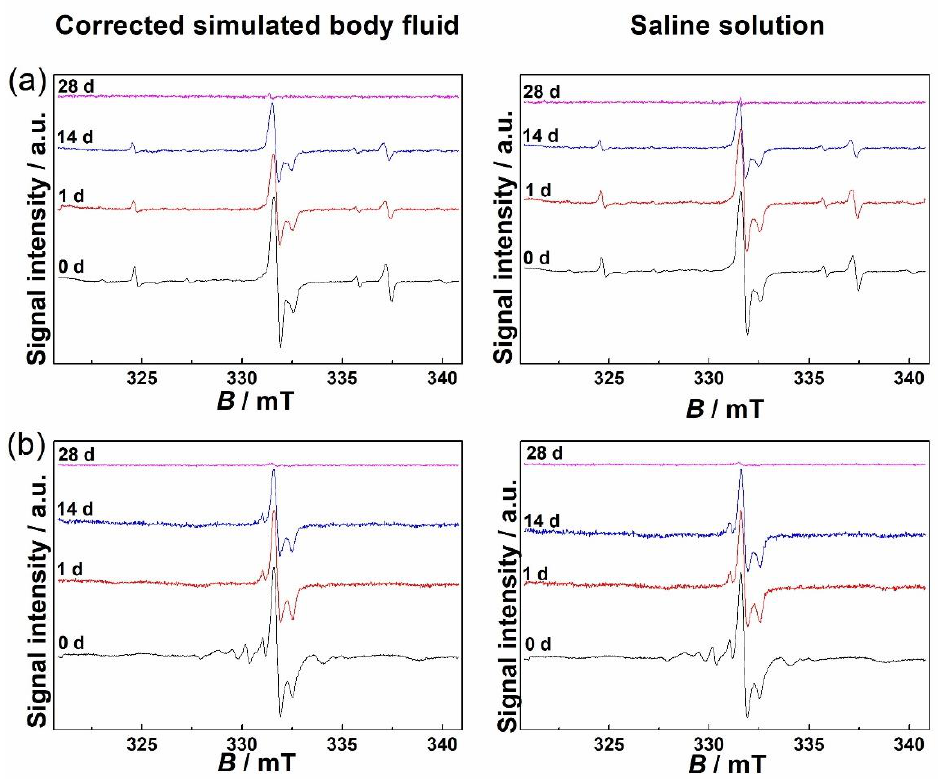
Figure 4. EPR spectra of ( a ) non-substituted hydroxyapatite (HAP) and ( b ) Mg-substituted HAP (Mg-HAP) irradiated to 25 kGy and after immersion in corrected simulated body fluid (c-SBF) and saline solution (SS) for 1 – 28 days at 37 °C.